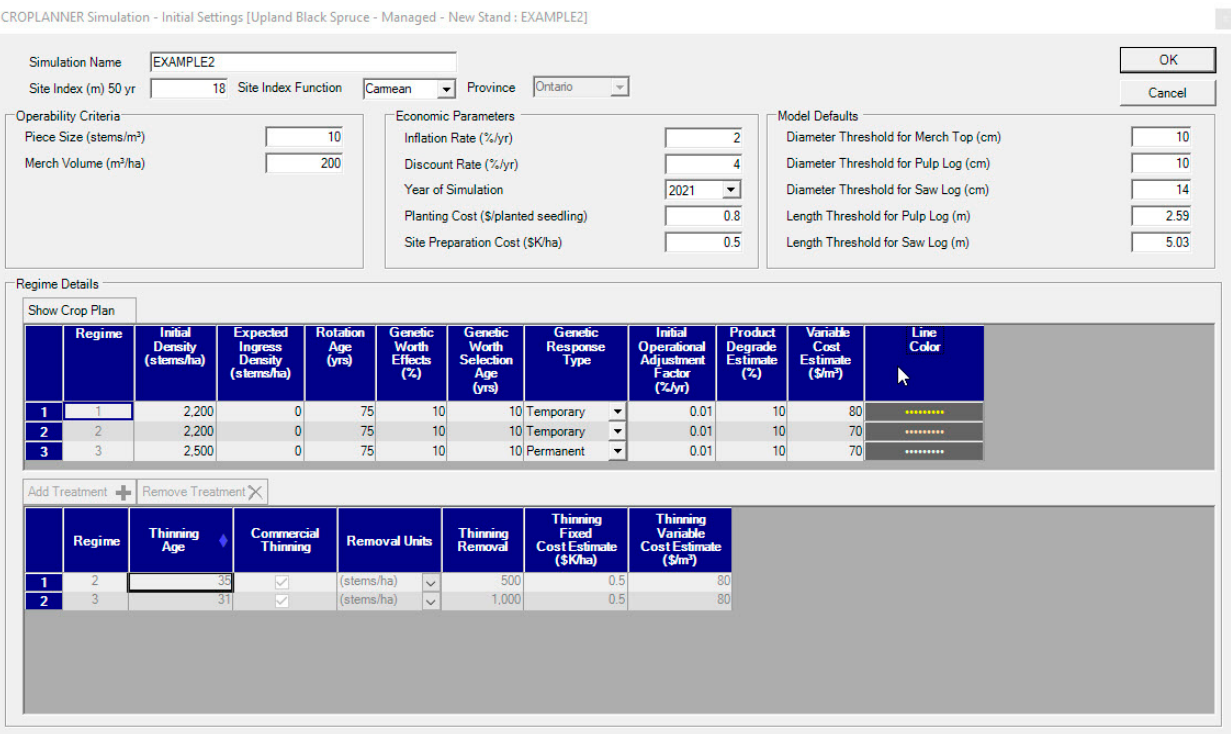
Figure A4. Exemplifying the automated crop plan selection capability of the CP DSS in regard to determining the optimal IE + CT regime within upland black spruce plantations via the deployment of the Value Management Optimizer–IE+CT. Specifically, the auto-populated input GUI dialog is informed from the optimizer’s output and includes the optimal IE + CT-based crop plan set along with the required regime-specific input and the carried forward operability targets, economic parameter settings and model (merchantability limit) defaults.